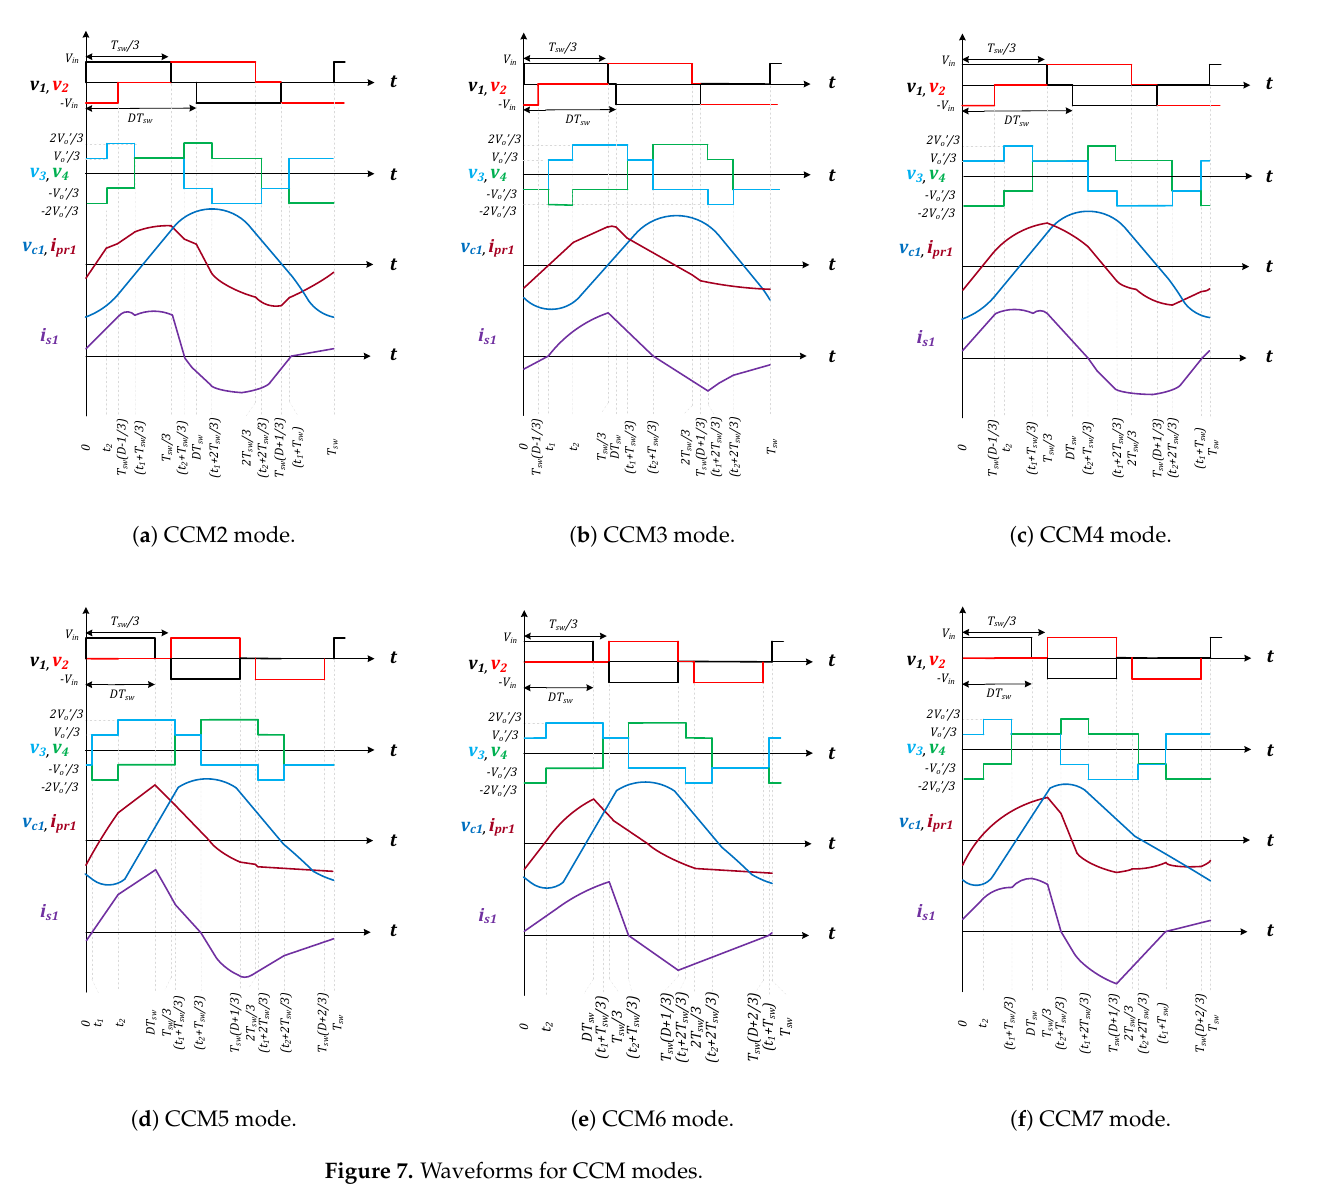
Figure 7. Waveforms for CCM modes. Table 1. CCM mode